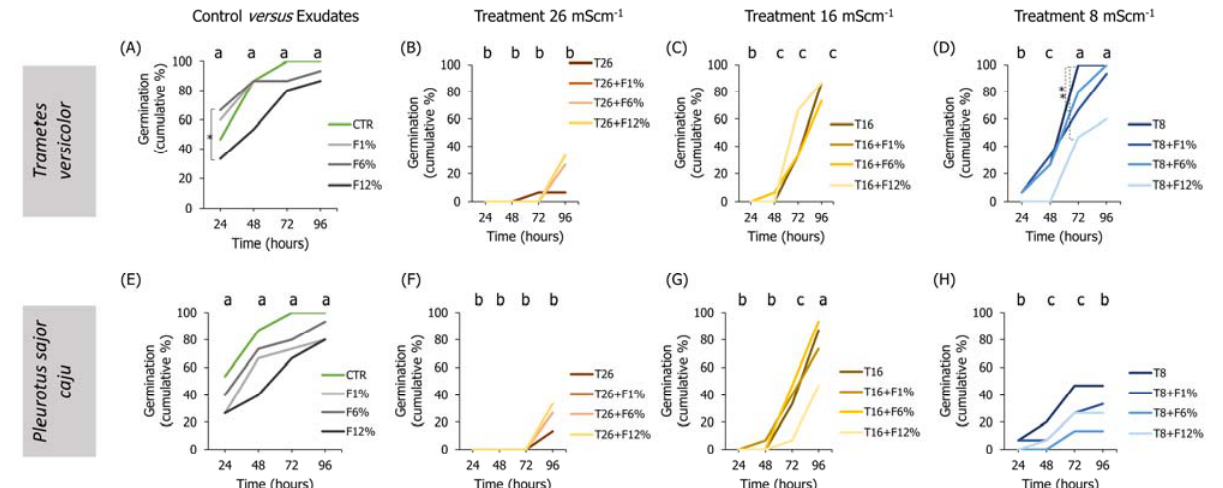
Figure 2. Lens culinaris germination rates, at 96 h, in natural soil salinized at three different levels (8, 16, and 26 mS · cm − 1 , designated as T8, T16, and T26, respectively) and supplemented with fungi exudates at three levels (1%, 6, and 12%, designated as F1%, F6%, and F12%, respectively). Graphics ( A – D ) present the results obtained from soil moistened with Trametes versicolor exudates, and graphics ( E – H ) present the results obtained from soil moistened with Pleurotus sajor caju exudates. CTR stands for control soil. Letters (a, b, c) stand for homogenous groups assessed only between CTR and the salinity treatments within each observation time for the germination endpoint (24, 48, 72, or 96 h; Holm ‐ Sidak, p < 0.05). The * stands for statistical differences between treatments within each time period (Holm ‐ Sidak, p < 0.05).